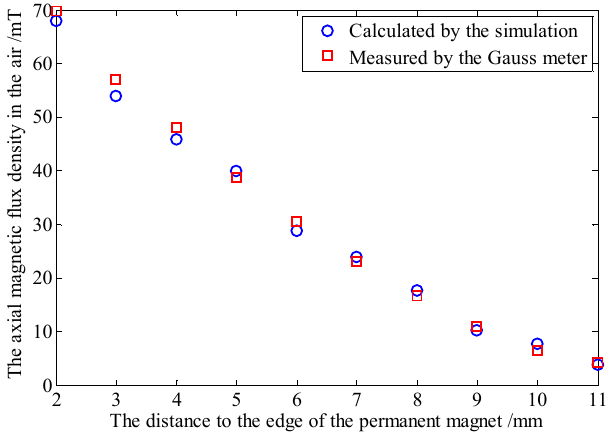
Figure 4. The comparison of the data obtained by the simulation and the Gauss meter.